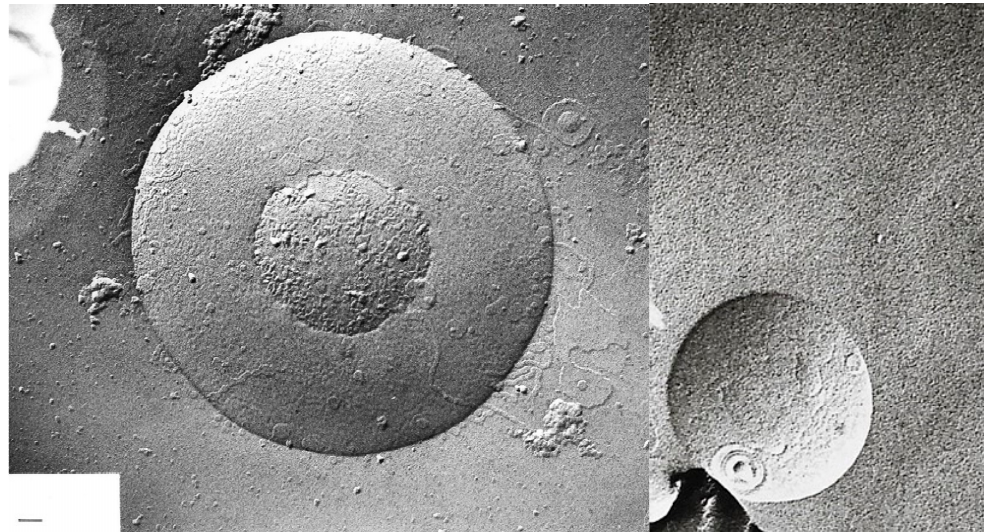
Figure 8. Freeze-fracture electron microscopy of mixed liposomes consisting of 25% MPL and 75% egg lecithin after 89 days; magnification ×67,500; bar = 100 nm.